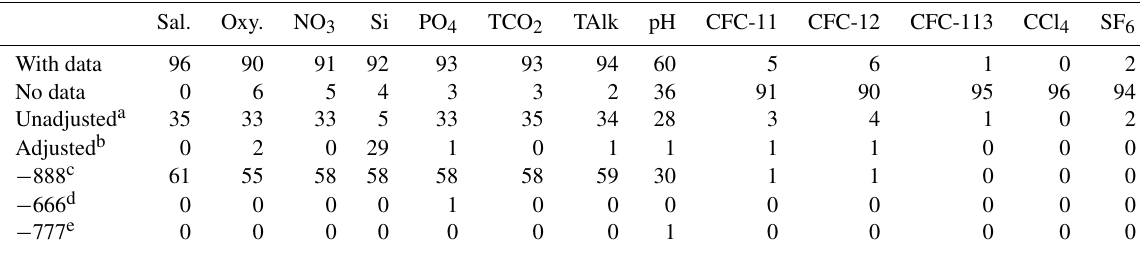
a The data are included in the data product file as is, with a secondary QC flag of 1. b The adjusted data are included in the data product file with a secondary QC flag of 1. c Data appear of good quality but have not been subjected to full secondary QC. They are included in data product with a secondary QC flag of 0. d Data are